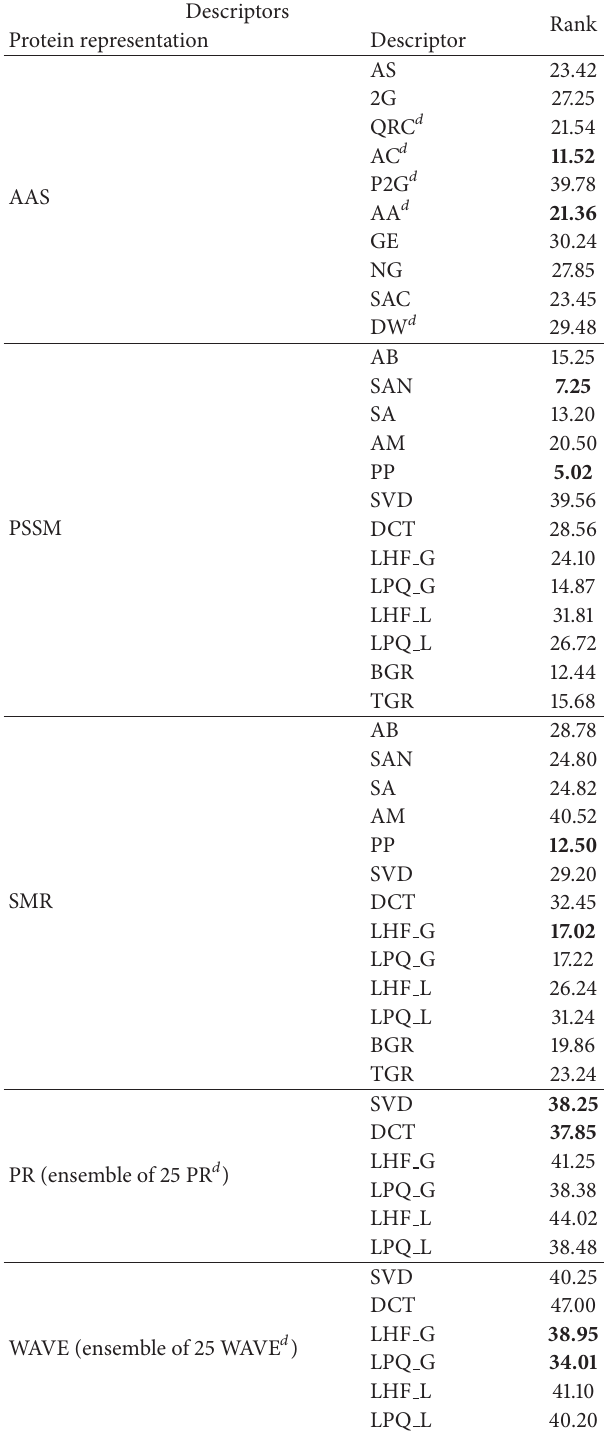
Table 3: Comparison among the different feature extractors in terms of the statistical rank on the different datasets. The 2 best descriptors for each representation are in